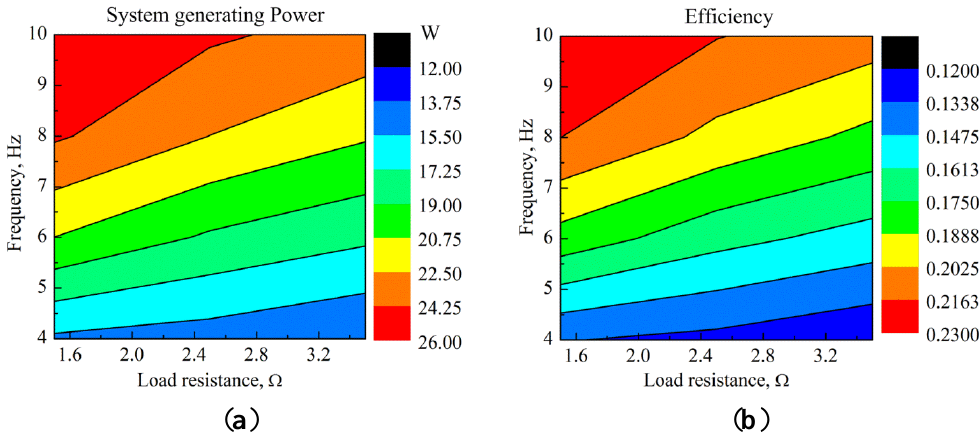
Figure 12. ( a ) System generating power, and ( b ) efficiency at various load resistances and